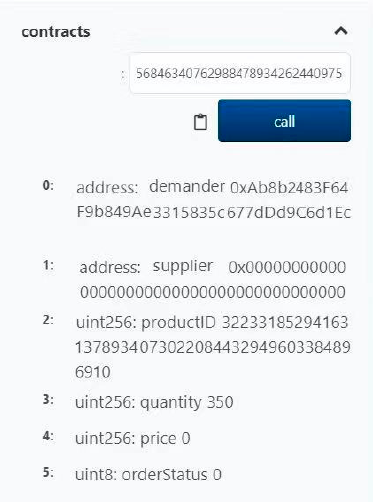
Figure 4. Contract specific information for demand task release.